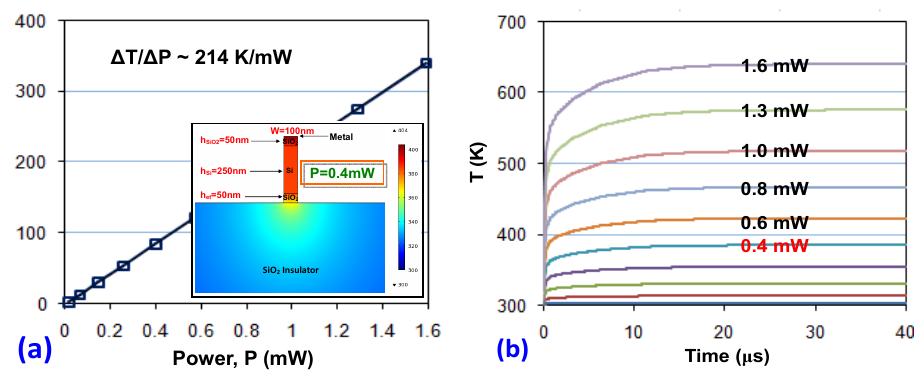
Figure 11. ( a ) The stable temperature variation as the power increases; inset: the simulated temperature profile when a 10 µ m-long silicon hybrid plasmonic waveguide is heated by an power of 0.4 mW; ( b ) the temporal response when it is heated with different powers [107].